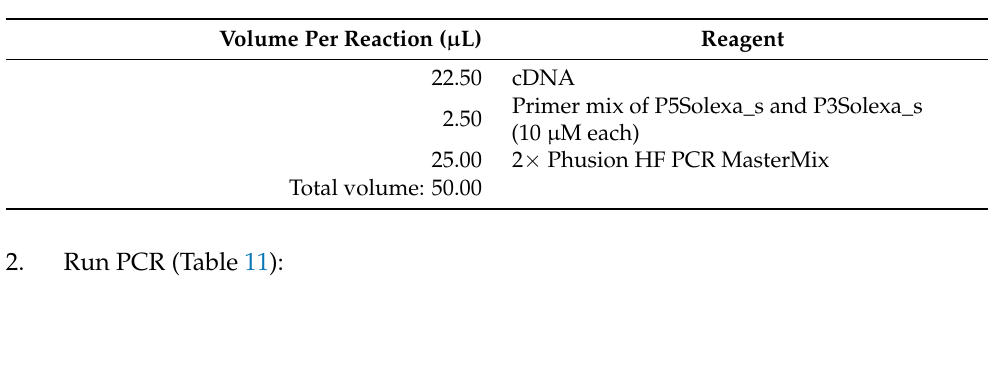
Table 11. PCR Scheme for Preamplification of cDNA.